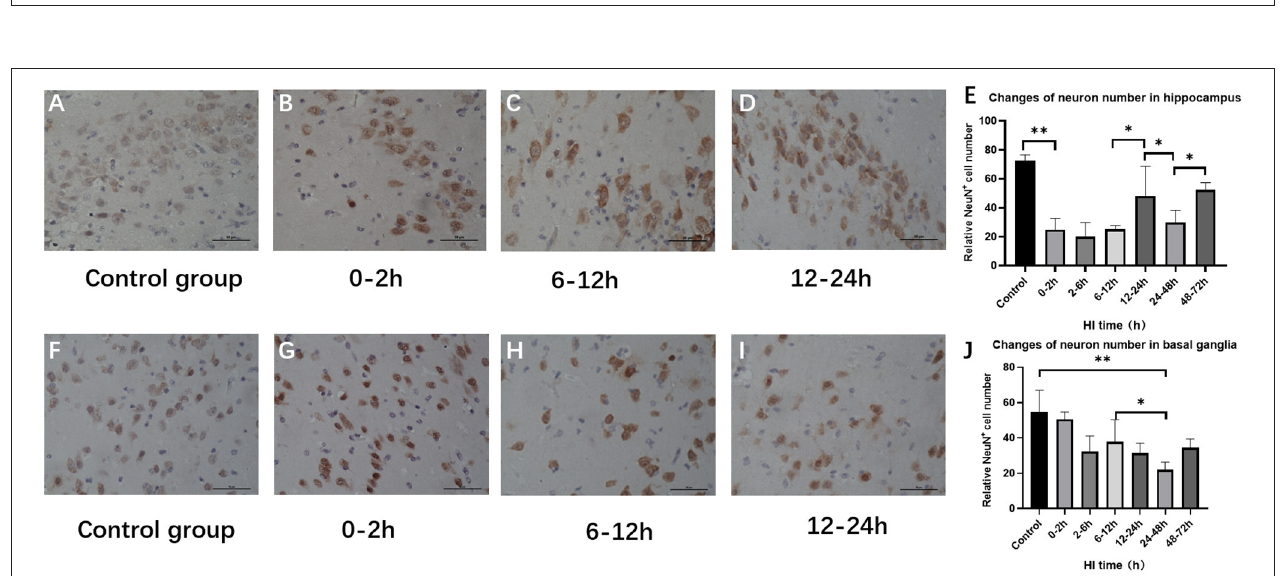
FIGURE 5 | Changes in the number of NeuN-positive cells in the hippocampus and basal ganglia after HI ( × 400). (A) Immunohistochemical staining of hippocampal NeuN in the control group. (B–D) Immunohistochemical staining of hippocampal NeuN at 0–2 h, 6–12 h, and 12–24 h after HI injury. (E) The number of NeuN-positive cells in the hippocampus decreases at 0–12 h and increases significantly at 12–24 h after HI injury. (F) NeuN immunohistochemical staining of the basal ganglia in the control group. (G–I) NeuN immunohistochemical staining of the basal ganglia at 0–2 h, 6–12 h, and 12–24 h after HI injury. (J) Compared with the control group, there is no significant difference in the number of NeuN-positive cells in the basal ganglia at 0–6 h after HI injury, and the number of NeuN-positive cells at 24–48 h after HI injury is significantly reduced. ** P < 0.01, * P < 0.05, and data are expressed as mean ± standard deviation.